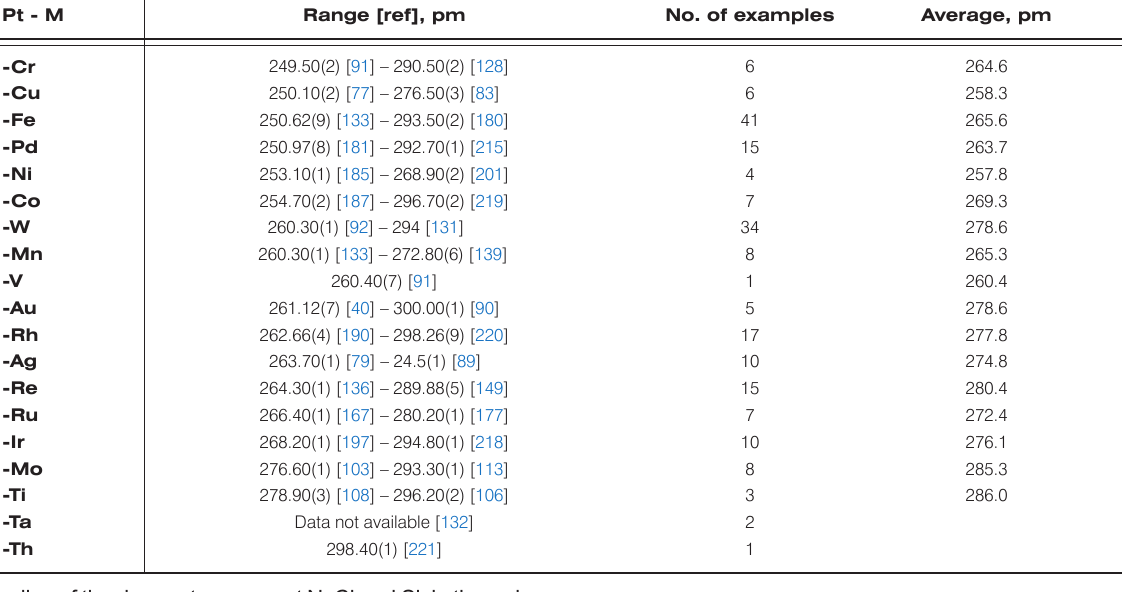
Table 7. Summary of the Pt-M bond distances in Hetero-binuclear Platinum Compounds (M = transition metal and thorium) Pt - M